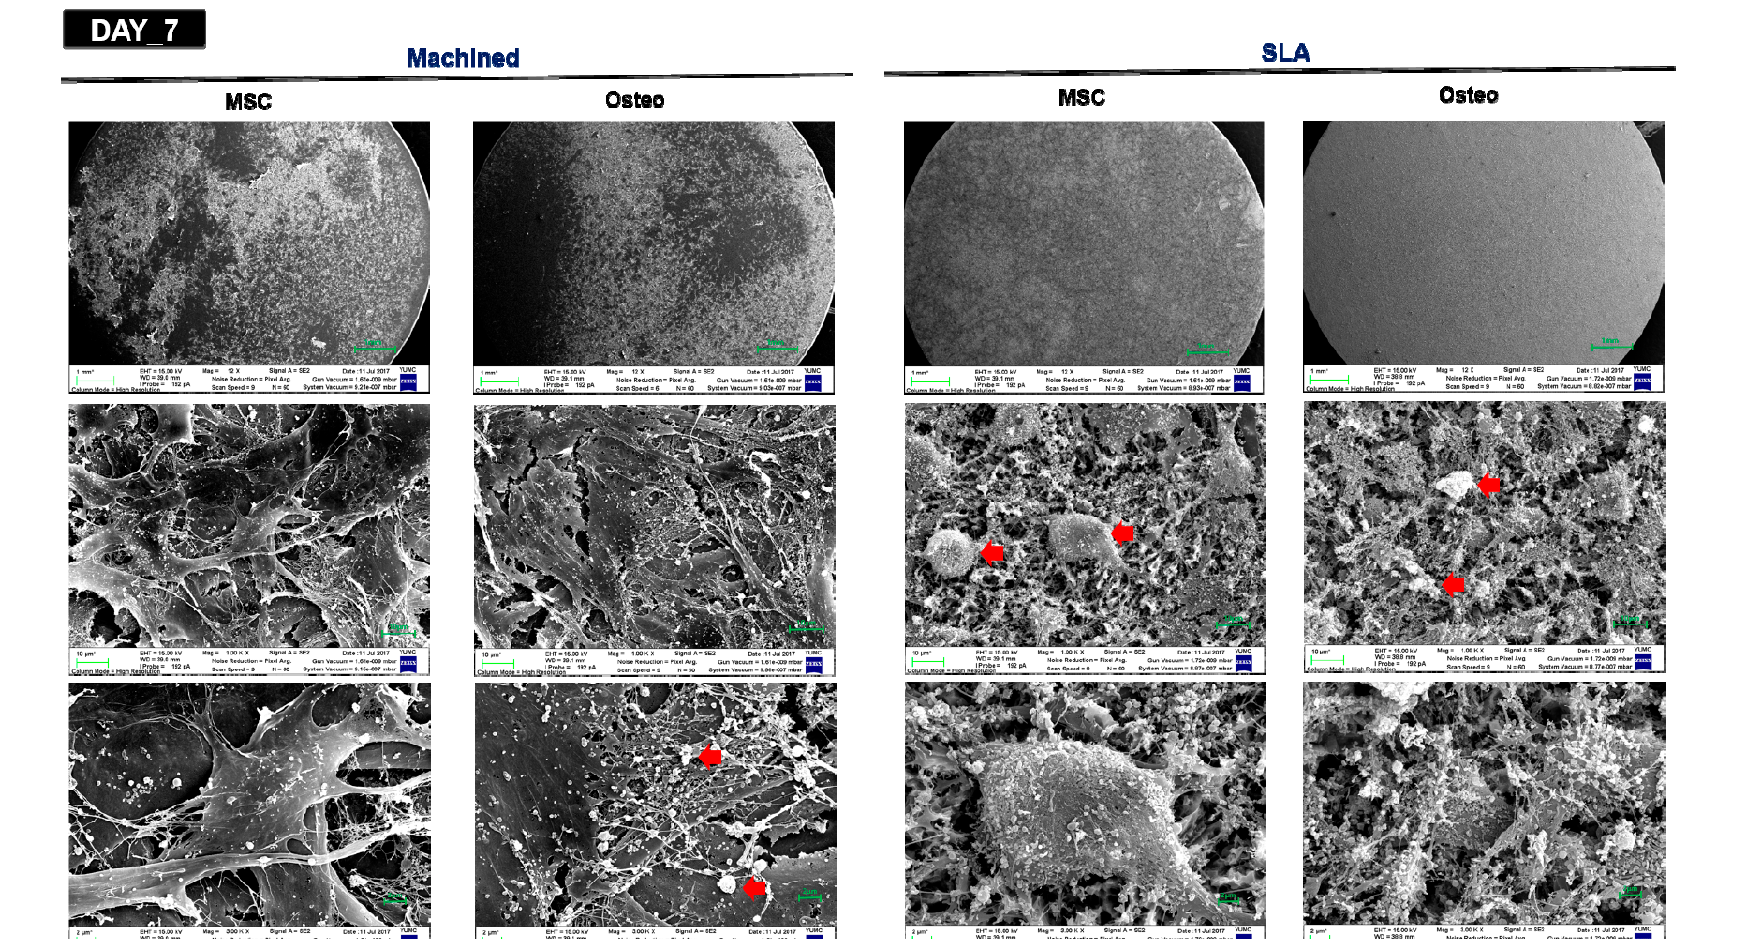
Figure 4. SEM images of d-hMSCs cultured with basic MSC culture medium (MSC) and osteogenic differentiation medium (osteo) on machined and SLA-treated titanium surfaces at 1, 5 and 7 days after initial culturing at three different magnification levels (upper 12×, middle 100× and bottom 3000× magnification; red arrows indicate mineralized crystalline-like structure).